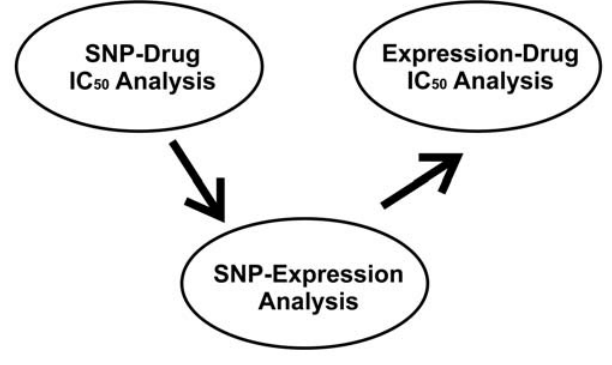
Figure 3. Strategy applied in these studies. A genome-wide SNP association study was performed with a drug-related phenotype, gemcitabine or AraC cytotoxicity (IC 50 ). SNPs associated with cytotox- icity (p , 10 2 3 ) were used to perform an association study with 54,000 expression probesets to identify SNPs that were associated with both gene expression (p , 10 2 6 ) and with gemcitabine or AraC IC 50 . Finally, an association study was performed with gene expression and gemcitabine or AraC IC 50 to identify SNPs that might be associated with drug IC 50 values through an influence on gene expression.